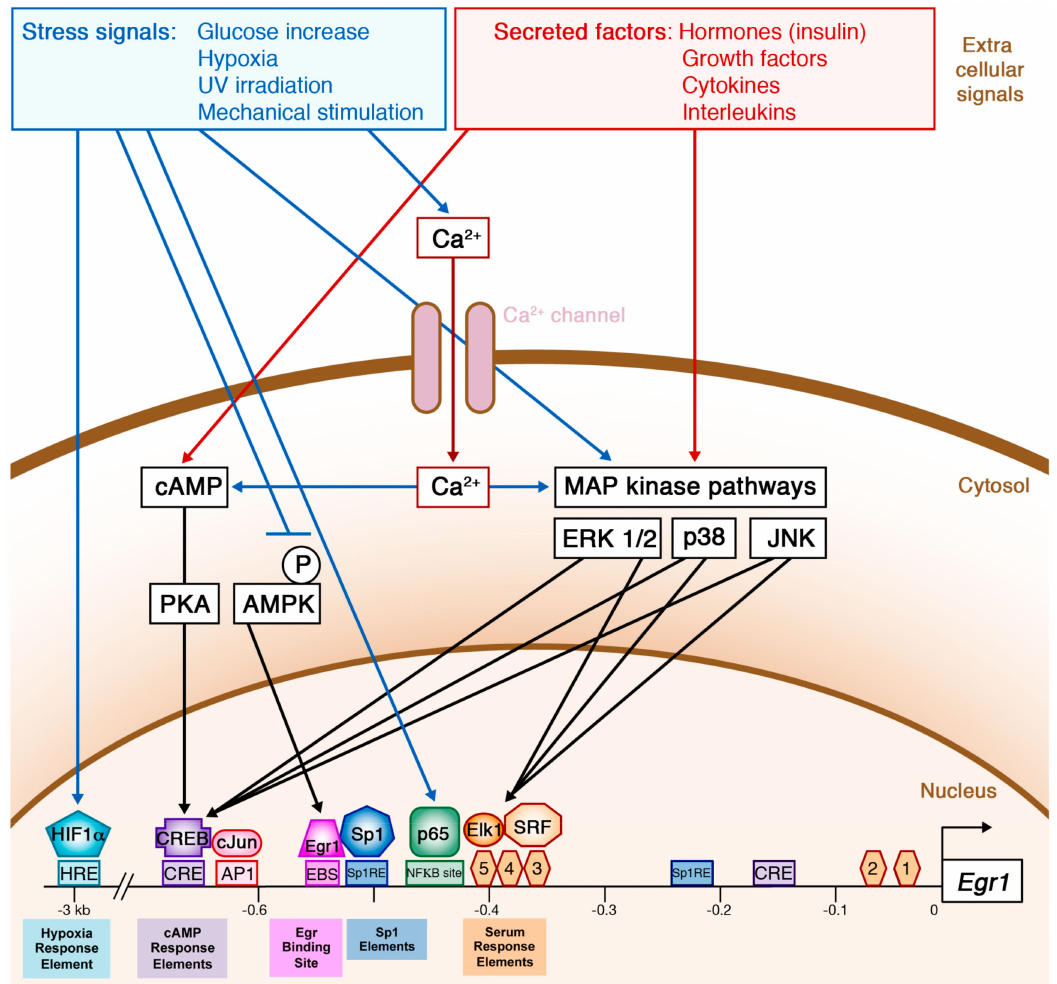
Figure 2. Schematic representation of the external stimuli that regulate Egr1